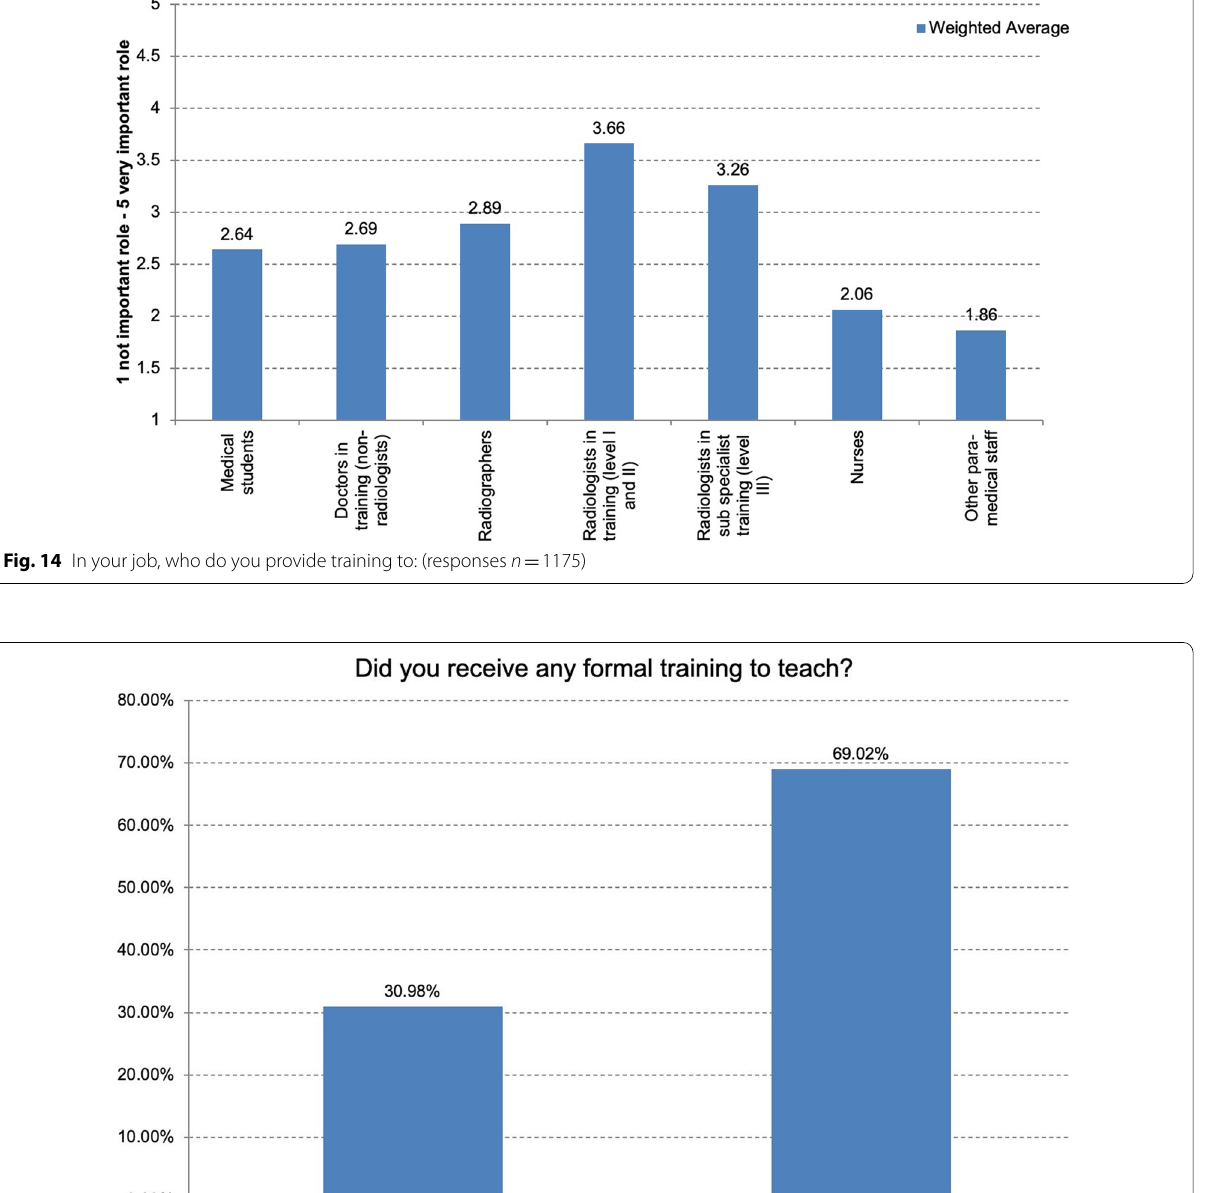
Fig. 15 Did you receive any formal training to teach? (responses n